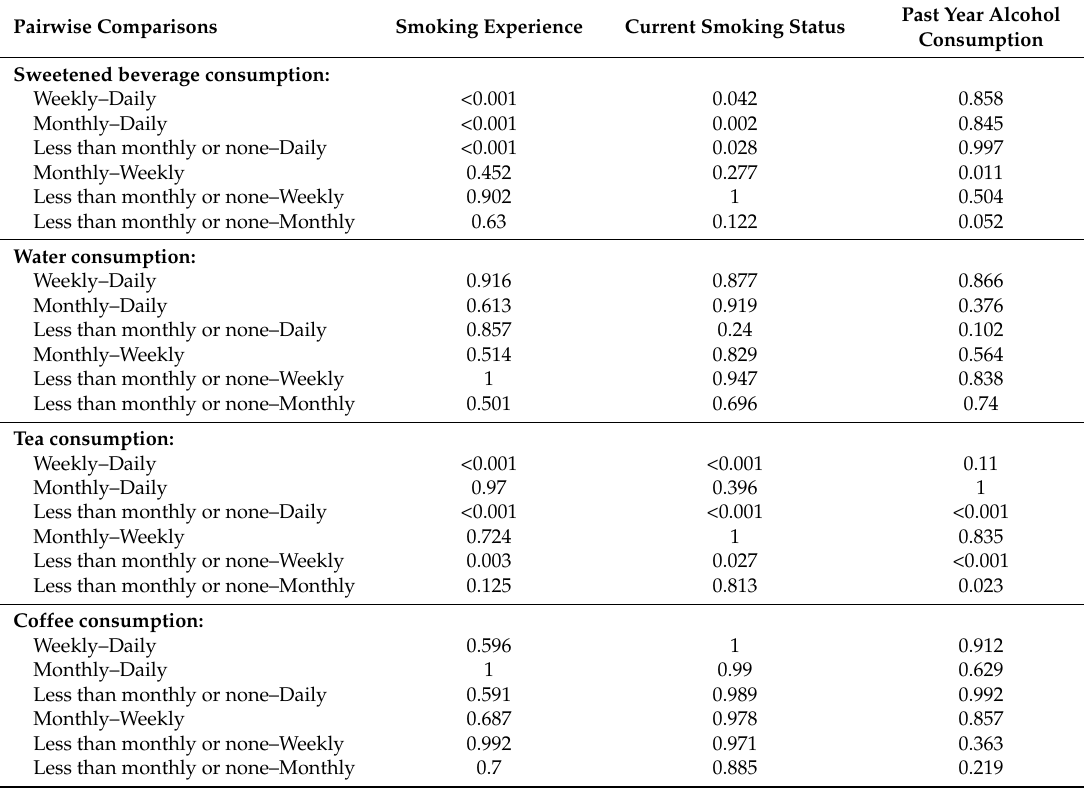
Table 3. Pairwise comparisons between each beverage intake frequency from Tukey’s honest significance tests. Data source: China Health and Nutrition Survey,